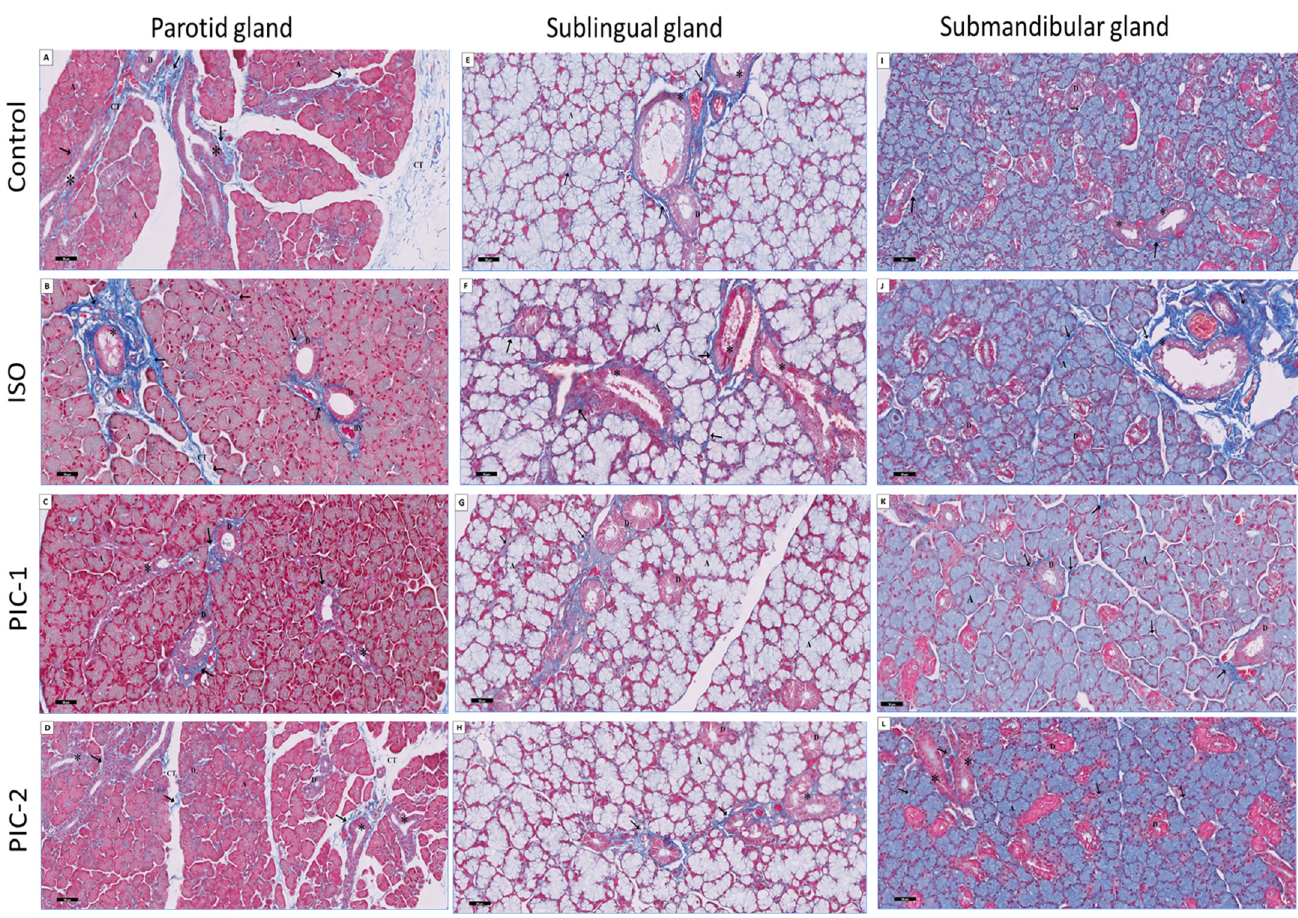
Figure 5. Masson trichrome-stained sections of the three salivary glands (parotid ( A – D ), sublingual ( E – H ), and submandibular ( I – L ) glands) of: control group showing scanty collagen fibers in the connective tissue septa between the lobules surrounding the blood vessels and large excretory ducts (*) are seen. The ISO treated group shows marked deposition of abundant collagen fibers in the connective tissue septa between the lobules that extended to surround the intralobular secretory acini and ducts. The PIC-1 group shows an apparent decrease of collagen fibers deposition in connective tissue septa between the lobules and around the intralobular acini and ducts. The PIC-2 group reveals scanty collagen fibers and appeared similar to the control group. A: acini, D: ducts, CT: connective tissue. (Masson trichrome; ×200).